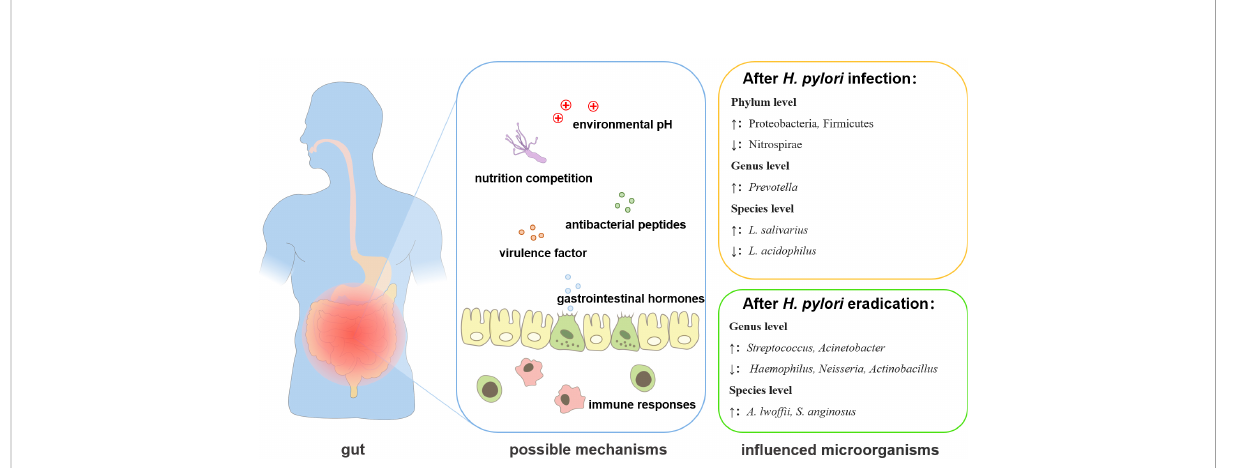
FIGURE 2 The changes and interactional mechanisms of H. pylori and gut microbiota. H. pylori infection can regulate the gut microbiota through 1. secretion of virulence factors; 2. mobilizing antibacterial peptides; 3. nutrition competition; 4. inducing or reducing the secretion of gastrointestinal hormones; 5. changing the pH of the environment; 6. affecting the immune response.7. eradication of